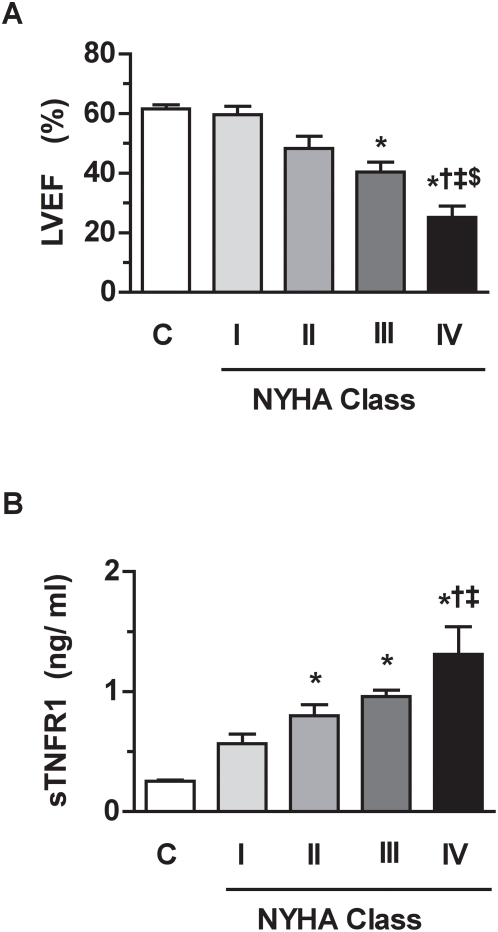
Relations between LVEF or blood sTNFR1 level and NYHA class in cardiac patients and healthy controls.The cohort displayed standard relations between functional NYHA class and LVEF (A) or blood sTNFR1 level (B). LVEF: left ventricular ejection fraction. sTNFR1: cleaved extracellular domain of TNFR1. Linear trends P<0.0001. *P<0.05 vs healthy controls (C). †P<0.05 vs NYHA class I; ‡P<0.05 vs NYHA class II; $P<0.05 vs NYHA class III.